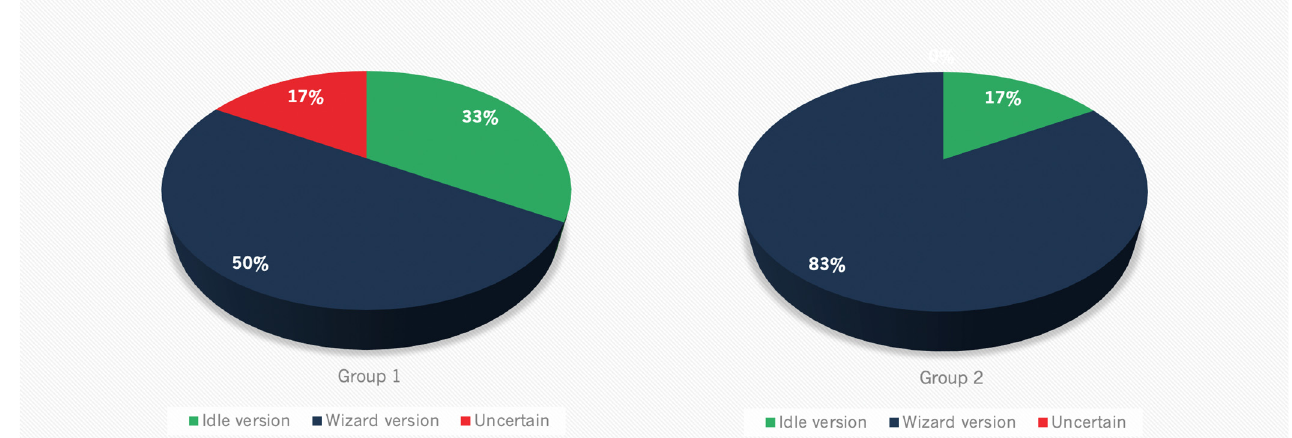
Figure 3. Preference questionnaire results showing ratio of subjects that preferred each version of the proposed system in each of the two groups.